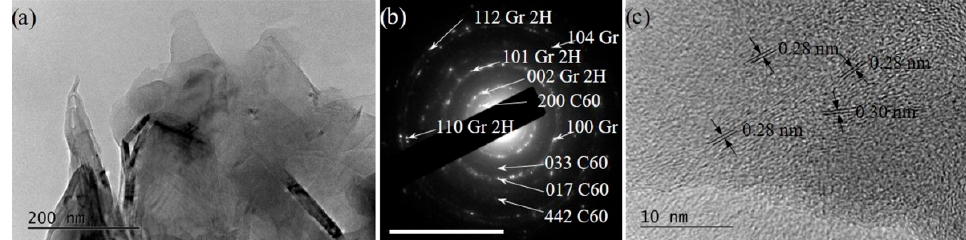
Figure 11. ( a ) An overview TEM image of LQ graphite irradiated with λ = 266 nm H 2 O, demonstrating a complex formation of few-layered graphene/defected graphene flakes agglomerated with 3D nanoparticles of C 60 fullerenes. ( b ) The SEAD pattern indicating the presence of the reflexes of hexagonal graphite and those of C 60 . The scale bar corresponds to 10 1/nm. ( c ) HRTEM of nano-sized 3D particles of C 60 with interplanar spacing varying between 0.28 and 0.30 nm.